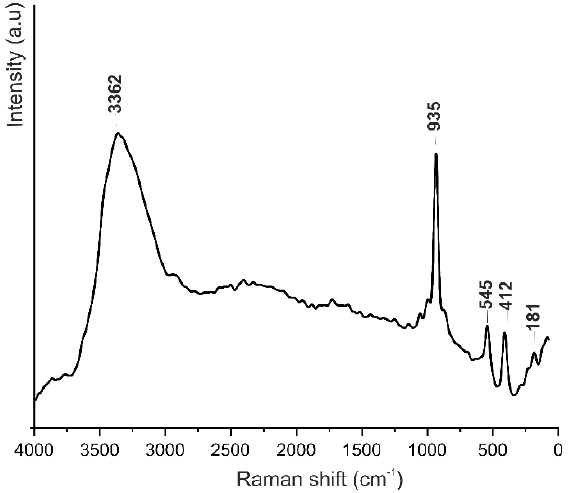
Figure 3. Raman spectrum of natural natrophosphate.